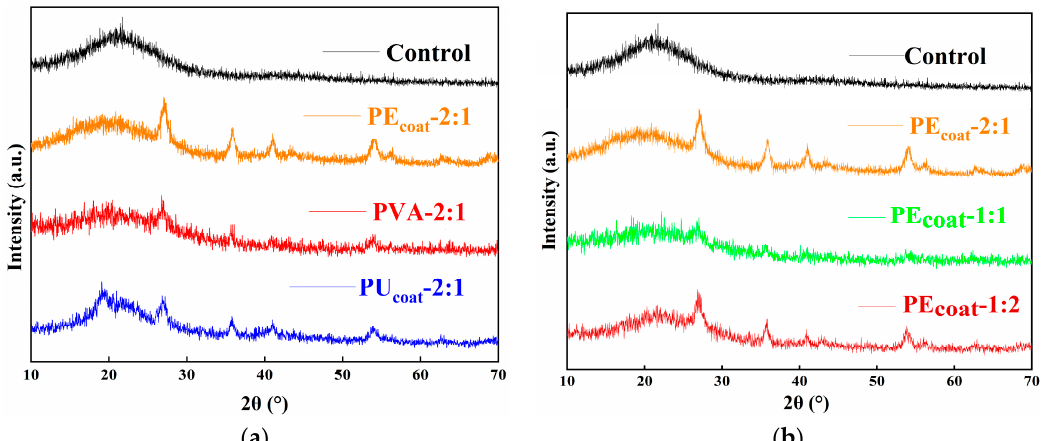
Figure 3. XRD patterns of fluorescent pigments under different conditions. ( a ) different types of binders ( b ) different ratios of PE to TiO 2 .